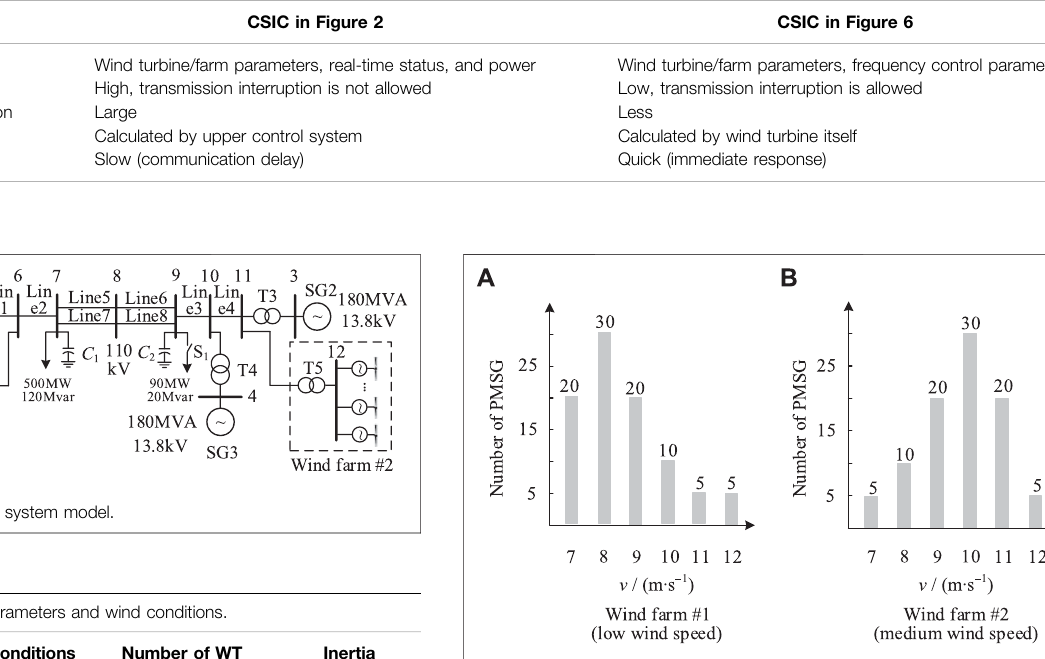
TABLE 1 | Comparison of CSIC in Figure 2 and Figure 6 .